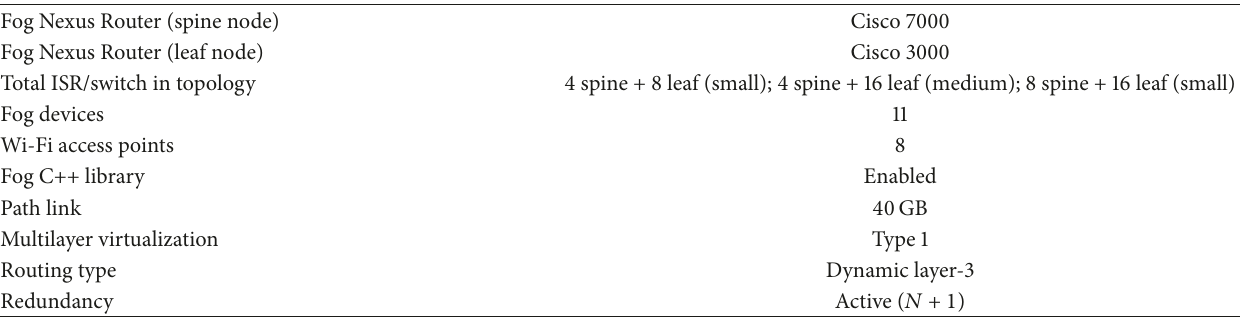
Table 1: Description of the physical topology for IoT